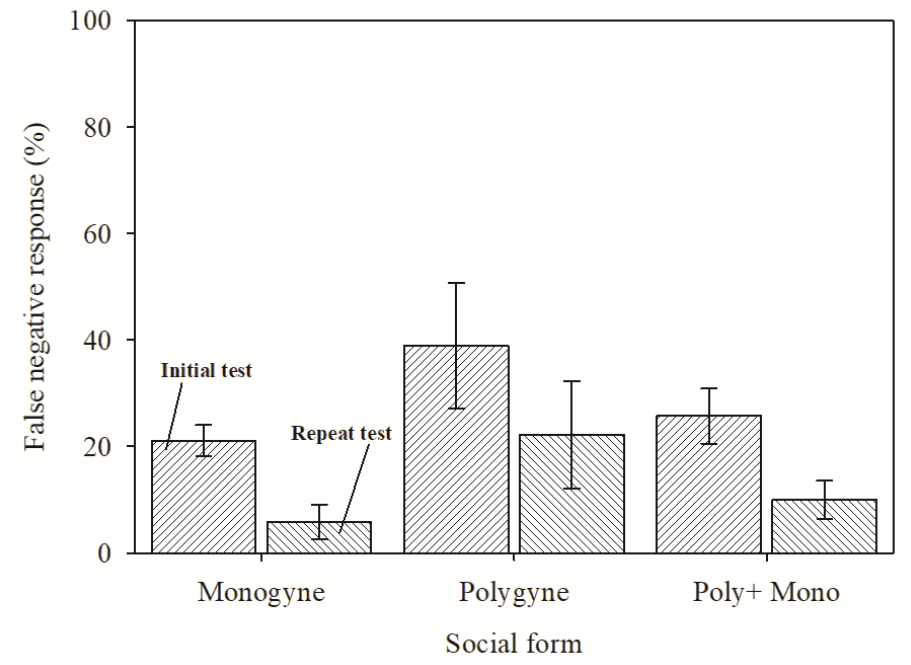
Figure 1. Mean ( ± standard error) proportion of InvictDetect TM test strips yielding a false negative response when using a single ant worker from monogyne and polygyne Solenopsis invicta fire ant colonies in the field. Ants were removed from nests, and the immunoassay was conducted in the field. The “poly + mono” grouping summarizes data from both social forms. The left bar for each group represents the immunoassay results from the initial worker ant, and the right bar represents the results from the second worker ant (repeated assay). To address the possibility of an e ff ect caused by di ff erent nests, the responses were compared by an analysis of variance that used “nest” as a classifier. “Nest” did not have a significant e ff ect on the false negative response rate in either monogyne (F = 0.76; df = 10, 41; p = 0.67) or polygyne (F = 0.28; df = 5, 12; p = 0.92) ants.